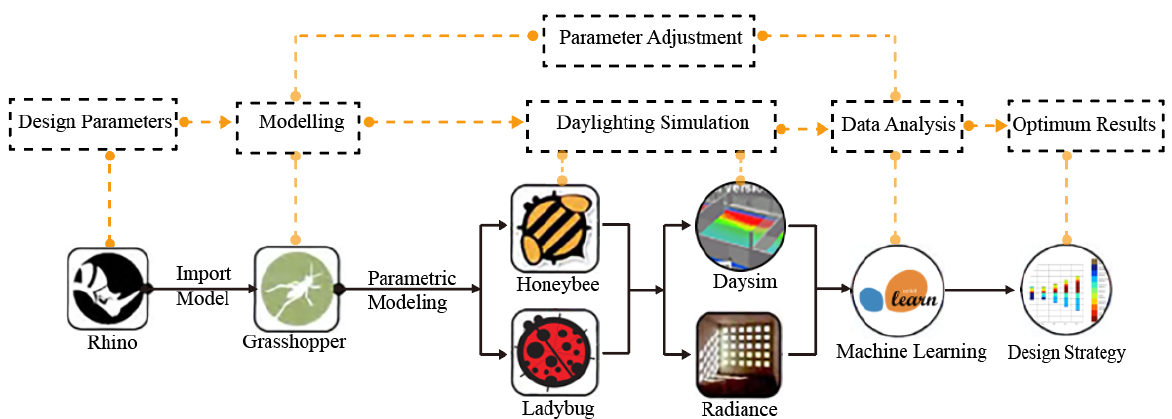
Figure 2. Flow chart of digital design of the light environment in waiting hall in cold regions.